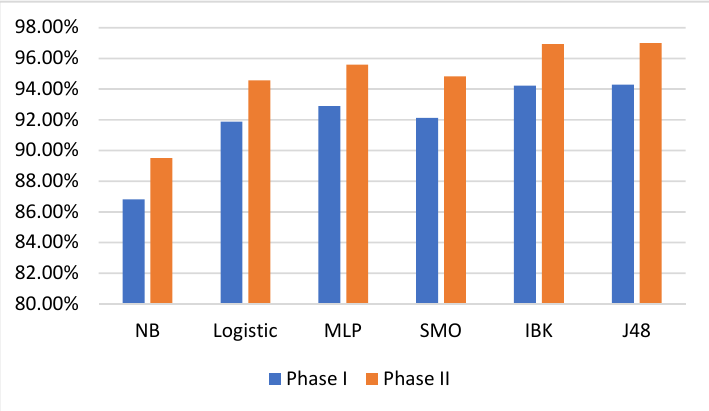
Figure 3. Classification accuracy in the two phases.